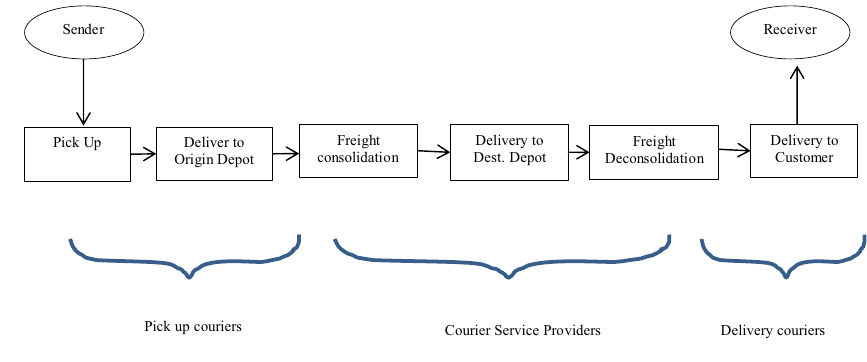
Figure 1. The typical domestic courier delivery Wang